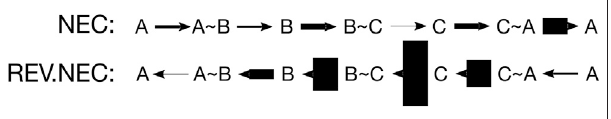
FIGURE 9 | Rates between the six negative existential types in NEC and REV.NEC, the widths of the arrows correspond to rate.